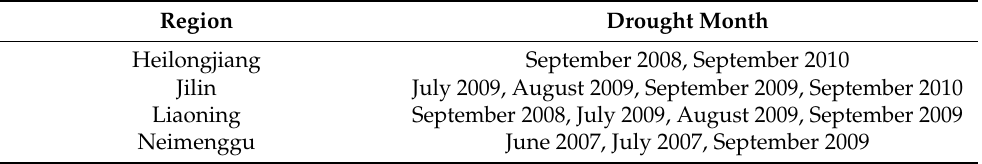
Table 6. The documented records of the major drought events from the China Drought Dataset